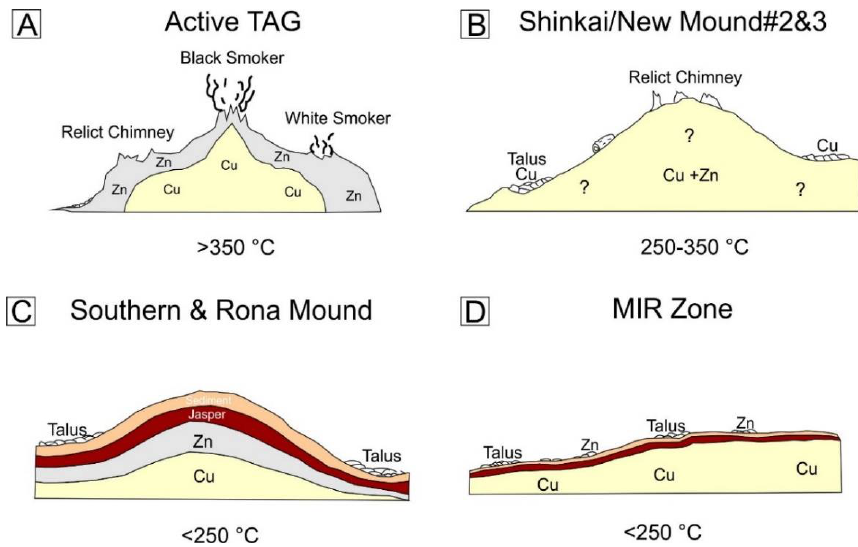
Figure 10. Schematic cross sections of the active TAG Mound and three extinct sites investigated during Blue Mining cruise. ( A ) Active TAG mound with black and white smoker edifices on the surface and metal-rich subsurface zones, modified from [18]. ( B ) Surface and sub-surface model for Shinkai Mound and New M. #2 & #3, with extinct chimneys and talus on the surface and inferred copper- and zinc-rich massive sulfides at depth. ( C ) Sub-surface structure of Southern Mound and Rona Mound, showing zone refining of metals concealed under a sediment-jasper cap. ( D ) Sub-surface model of the MIR Zone, with copper-rich massive sulfides under a thin cap of sediments and jasper. The stated temperatures reflect the state of the system, i.e., >350 °C active black smoker system with copper-rich mineral assemblages, 250–350 °C stand for an inactive system that has not undergone intense alteration yet and <250 °C intermediate to long ceased system with intense metal remobilization and zone refining. Cross sections represent the upper 15 m of the different sites and are not to scale.